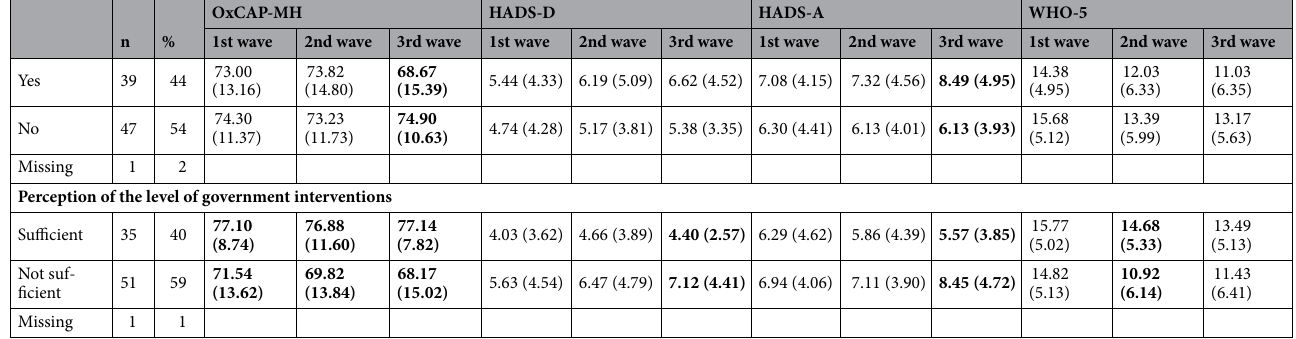
The detailed investigation of the differential impacts on the OxCAP-MH capability items found significant reductions in how respondents perceived their social networks. Although not statistically significant, reductions were also observed e.g. in terms of the likelihood of discrimination and assault, influencing local decisions and losing sleep over worries. However, some improvements were reported, for instance, in the appreciation of nature, access to interesting activities or employment, self-determination and feeling safe (Table 3). A visual presentation of the ranks of individual OxCAP-MH items at each timepoint can be seen on Fig. 2. This shows that the highest ranked capability items at each timepoint were the (lack of) limitation in daily activi- ties, likelihood of assault and discrimination. The lowest ranked capability items at each lockdown included feeling safe, appreciating nature and respecting and valuing people. Associations between change scores of the individual OxCAP-MH capability items and sociodemographic characteristics across the three lockdowns found diverse outcomes across subgroups (Table 4). People with mental health treatment prior to the pandemic reported significantly more limitations in most capability items across the lockdowns than the rest of the cohort. Those with a high level of social support had significantly better outcomes in terms of the likelihood of both discrimination and assault, respecting/valuing people and enjoying friendship/support than those without. Respondents who were satisfied with government measures reported